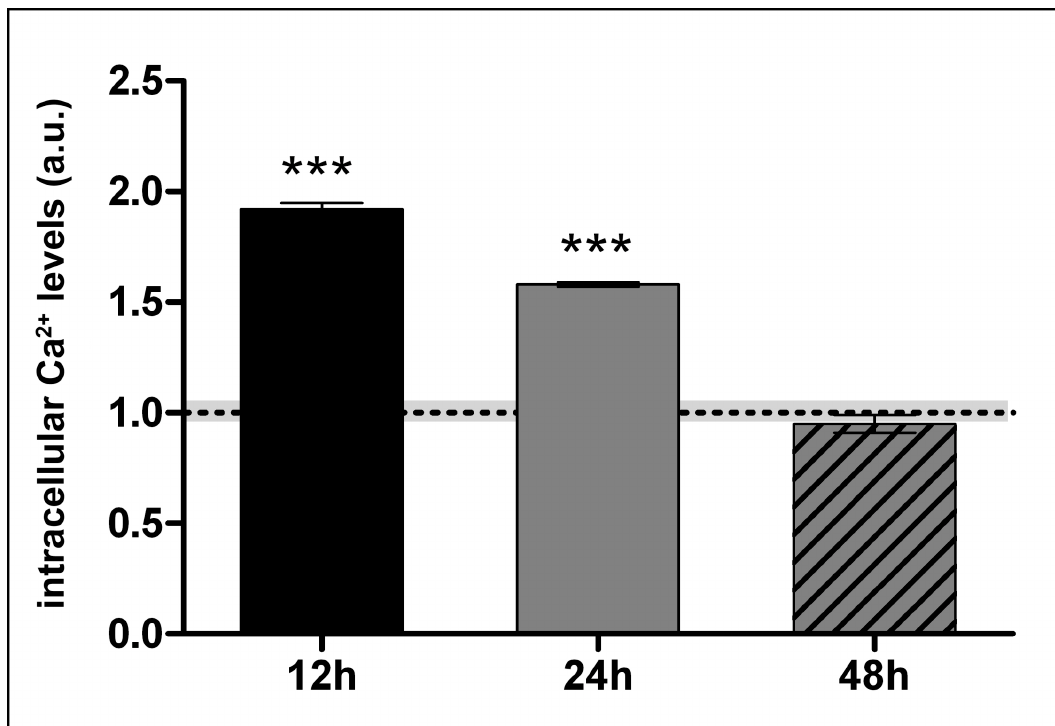
Figure 5. E ff ect of 0.3 µ M lanthionine treatment in 12 h, 24 h and 48 h on intracellular Ca 2 + levels in endothelial cells. Ca 2 + levels were detected using the fluorescent probe Fura 2-AM and were expressed as arbitrary units (a.u.), normalized to fluorescence intensity in lanthionine free control cells (dashed line). The columns represent the mean and error bars indicating the SD from three independent experiments; gray area represents the SD for control samples; p value versus untreated control = *** p < 0.001, (according to Student’s t -test). CTRL, control; Lan, lanthionine; Ca 2 + ,